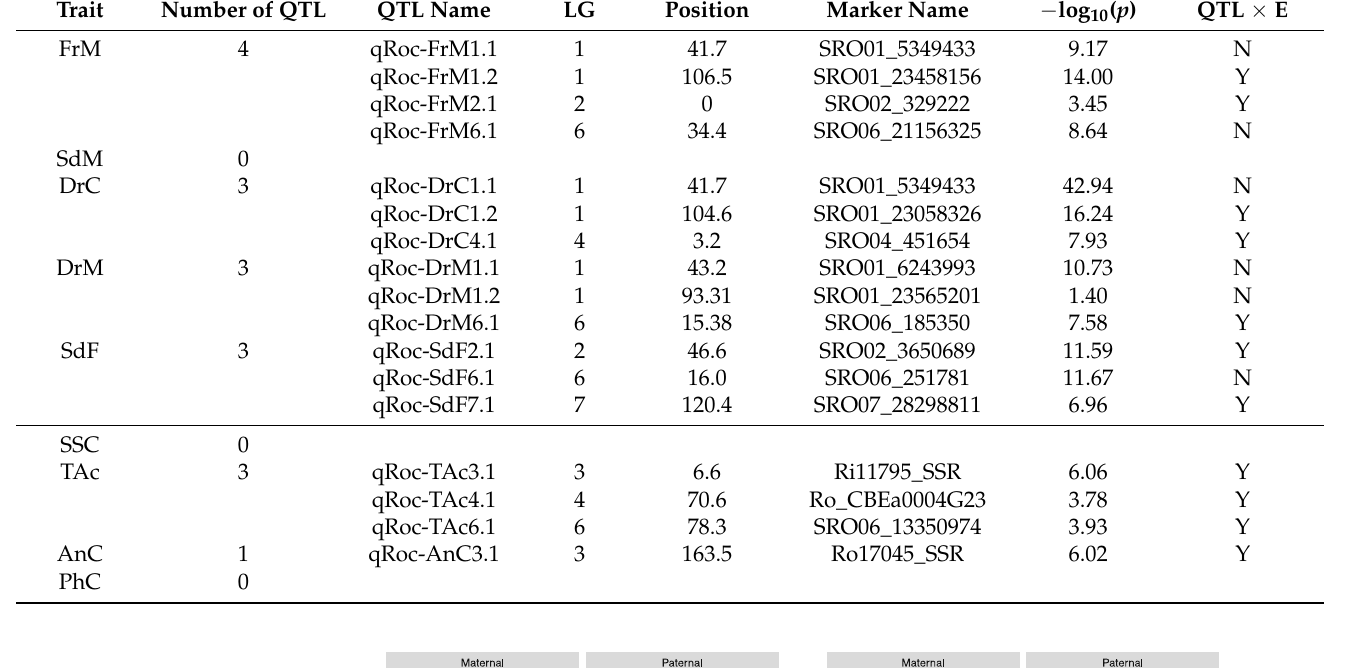
Table 5. Summary of QTL identified by single trait, multiple-environment analysis. FrM = fruit mass; SdM = seed mass; DrC = drupelet count; DrM = drupelet mass; SdF = seed fraction; SSC = soluble solid content; TAc = titratable acidity; AnC = anthocyanin content; PhC = phenolics content.